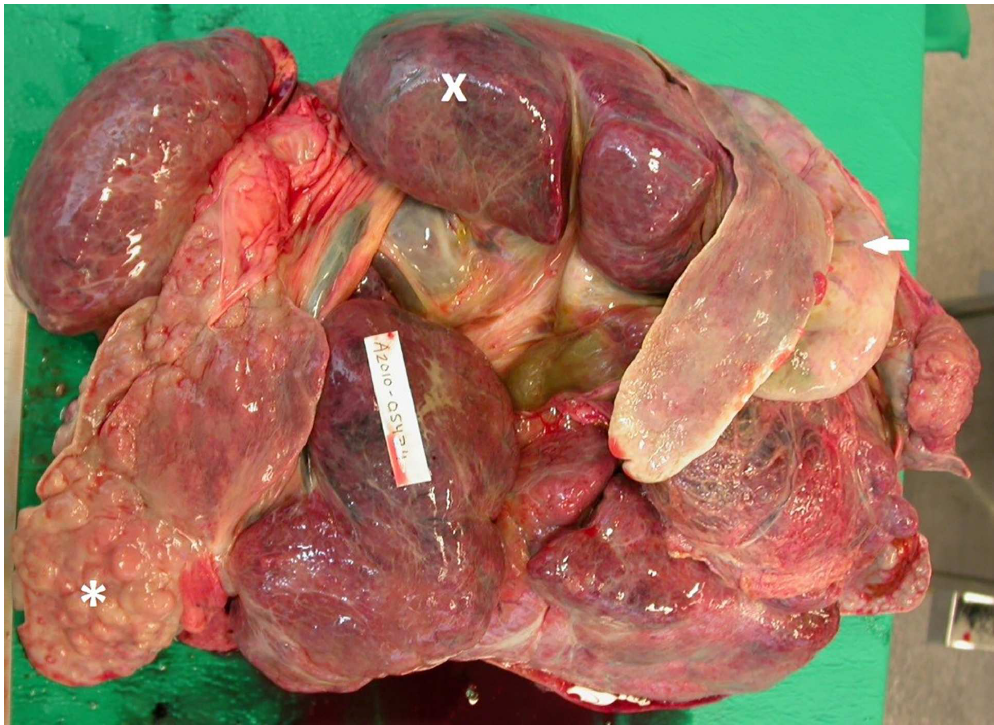
Fig 4. The liver of a grey seal ( Halichoerus grypus ) infected with Pseudamphistomum truncatum displaying chronic, severe cholangiohepatitis. Lobes vary from being markedly atrophic with only severely fibrotic and ectatic bile ducts and interveningconnective tissue remaining ( * ) to being swollen and congested with evidence of hepatic fibrosis and necrosis on cut surface (x). The gall bladderis markedly enlargedand has thick walls ( ⇦